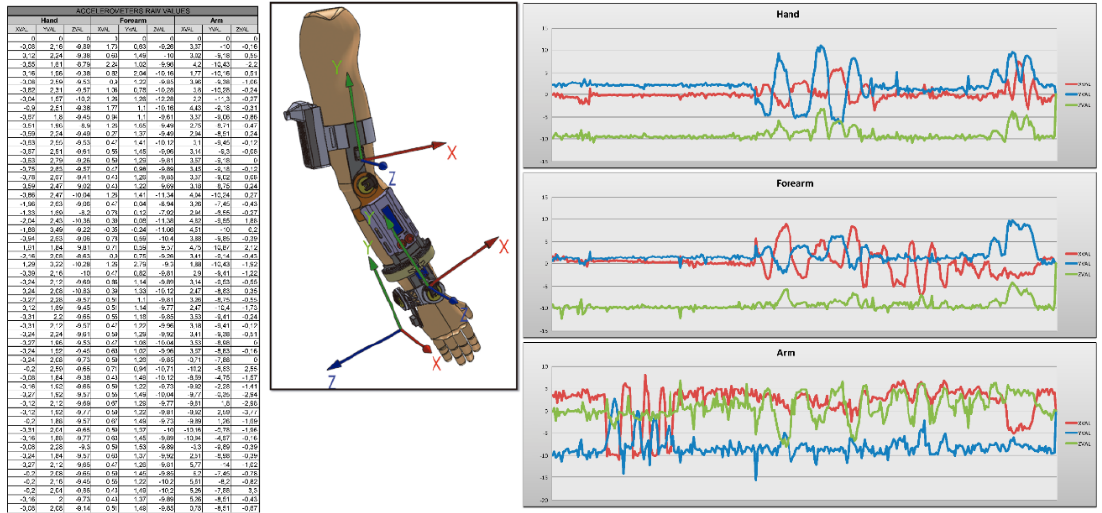
Figure 9. Data collected by accelerometers.